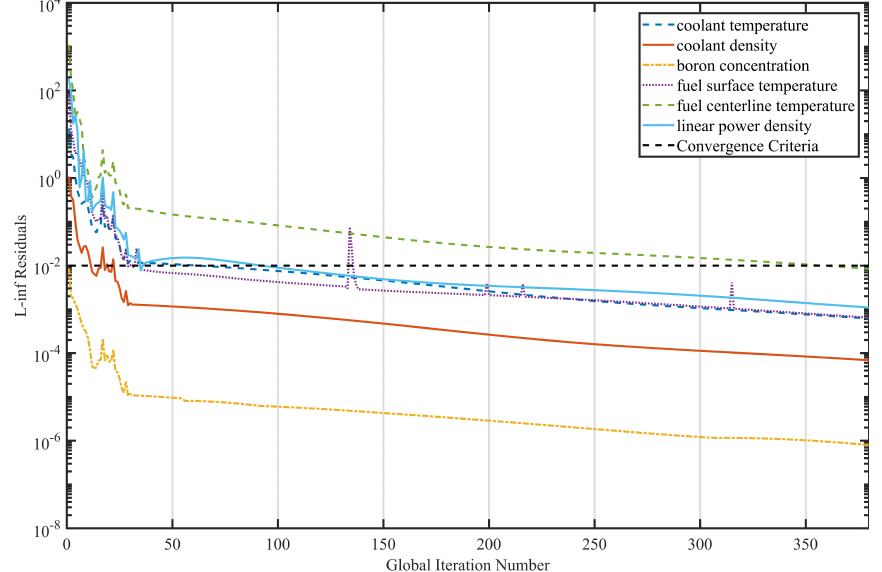
Figure 6. Details of the coupled steady-state convergence.